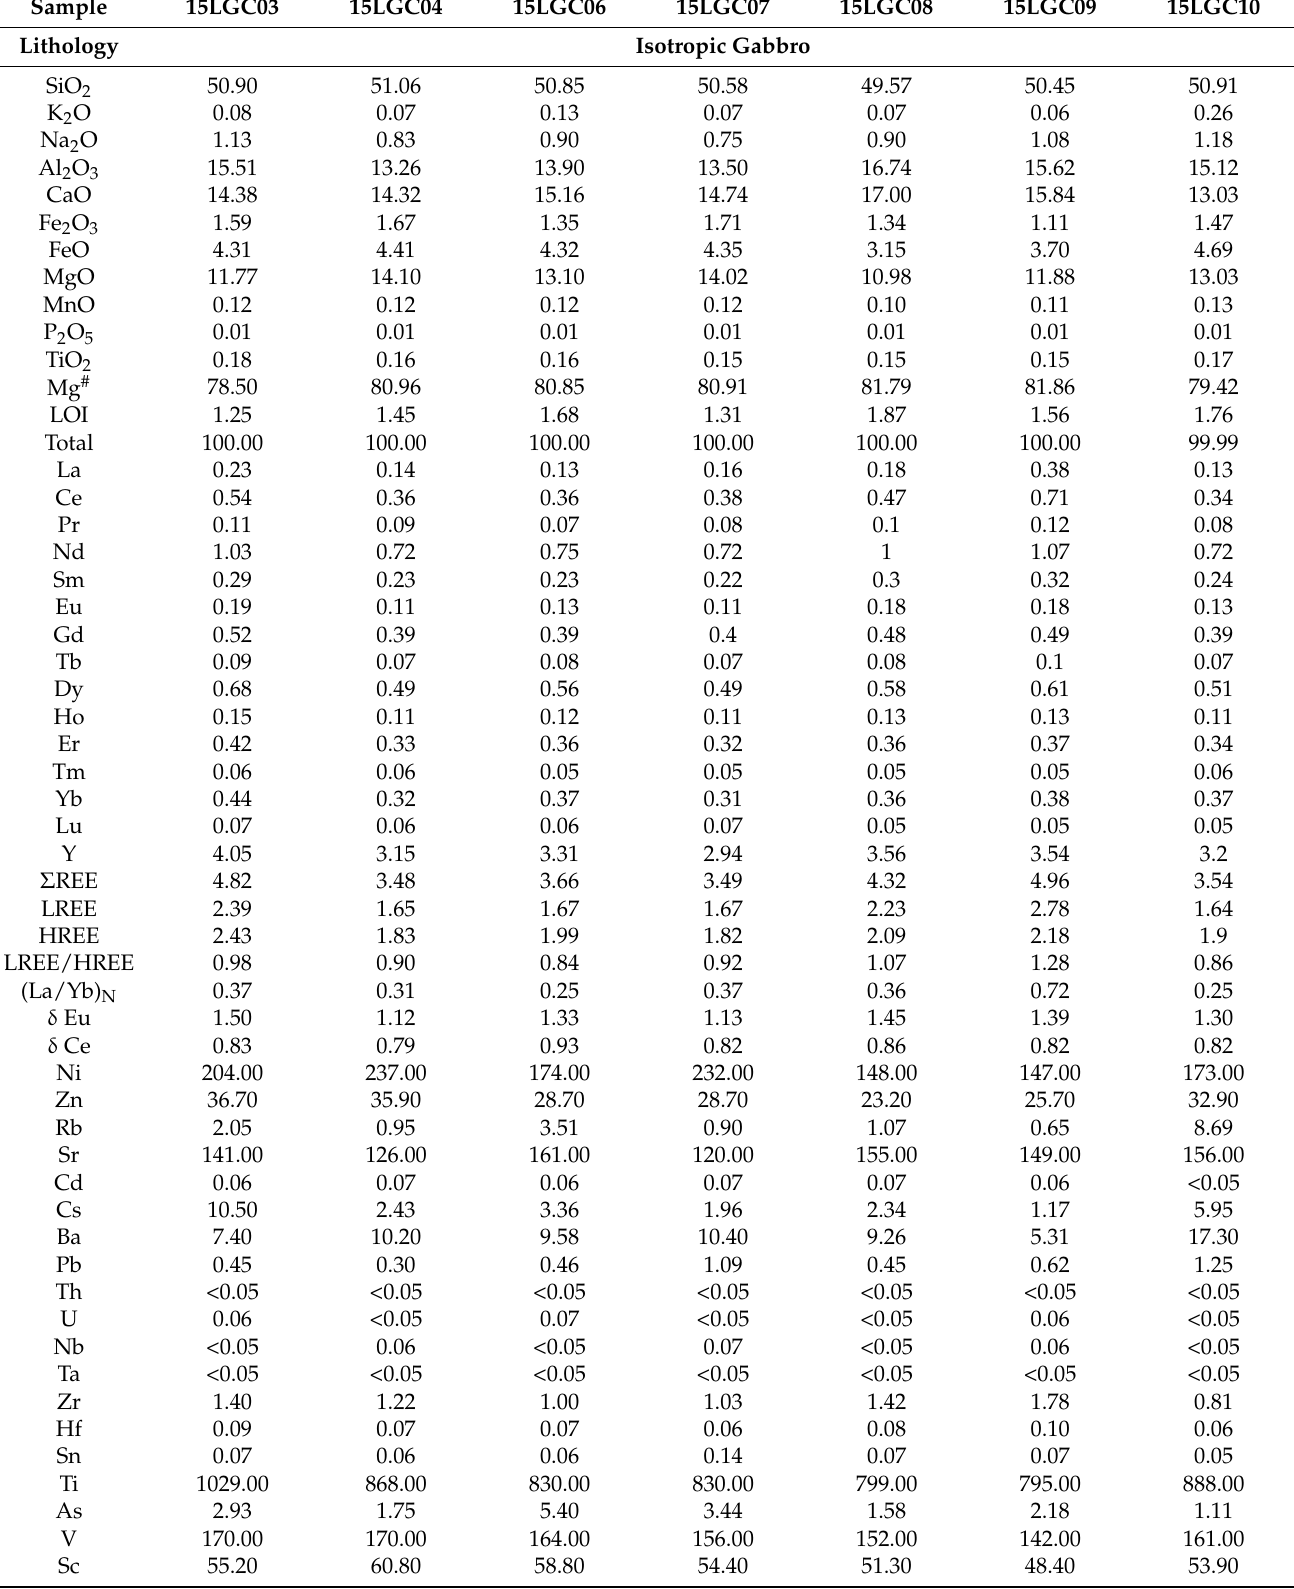
Table 1. Whole-rock analyses of major (%) and trace element (ppm) of gabbro, Laguoco,